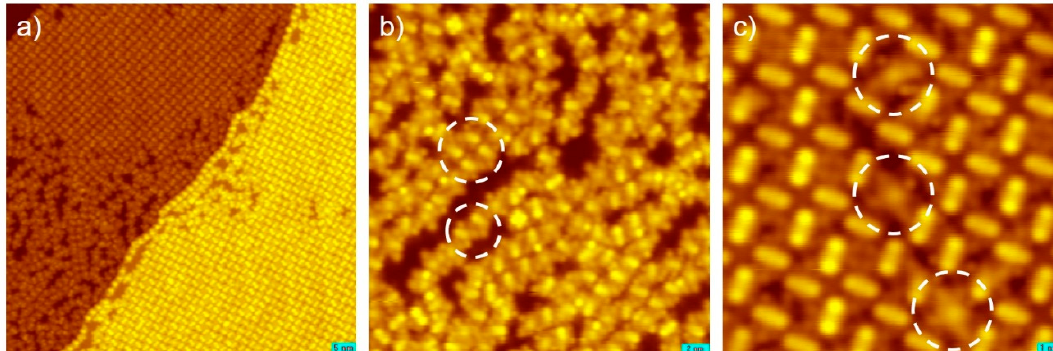
Figure A4. ( a ) Large-scale STM image of the Co(TAP) molecules adsorbed on Au(111) at high coverage and after being annealed at 523 K. ( b ) Enlarged STM images of a disordered domain in ( a ). ( c ) Enlarged STM images of a well-ordered self-assembly domain in ( a ). The intermediate DHC products are marked by the white dashed circles in ( b ) and ( c ). The blue scale bars in ( a – c ) correspondingly represent 5, 2 and 1 nm. Imaging conditions: ( a , b ) − 1.0 V, 30 pA; ( c ) − 0.3 V, 10 pA.